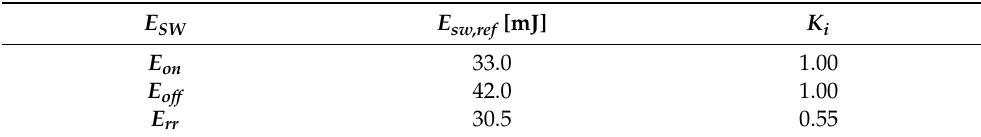
Table 1. Energy losses reference values and exponents used in Equation